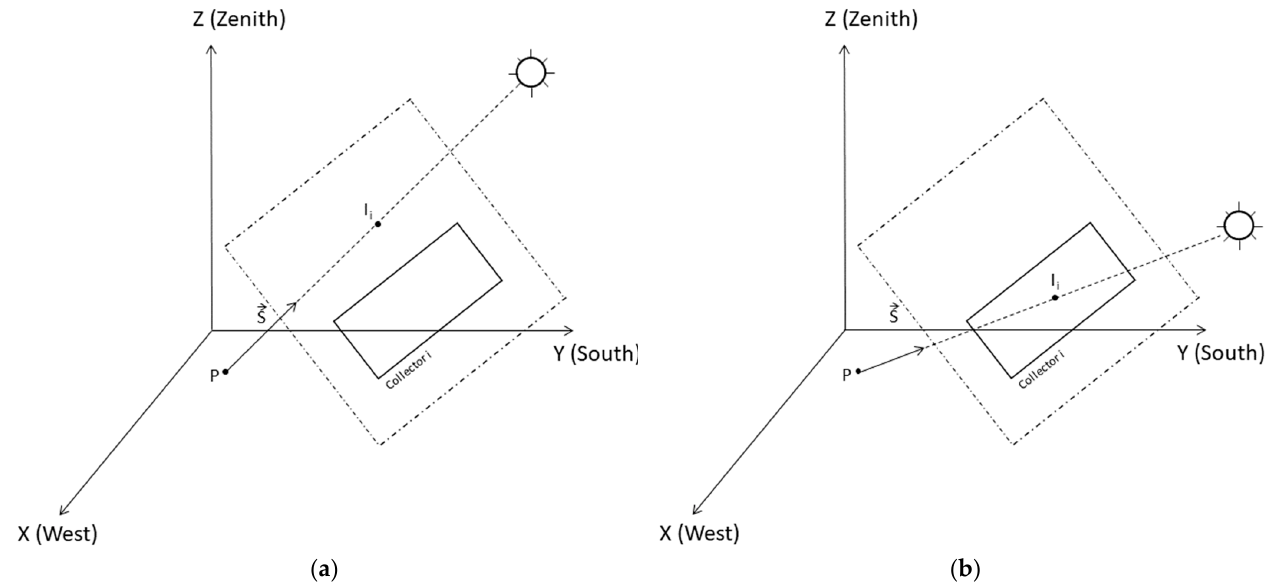
Figure 3. Graphical representation of the geometric problem to be solved to determine if the point P is shaded. ( a ) Case where P is not shaded; ( b ) case where P is shaded.